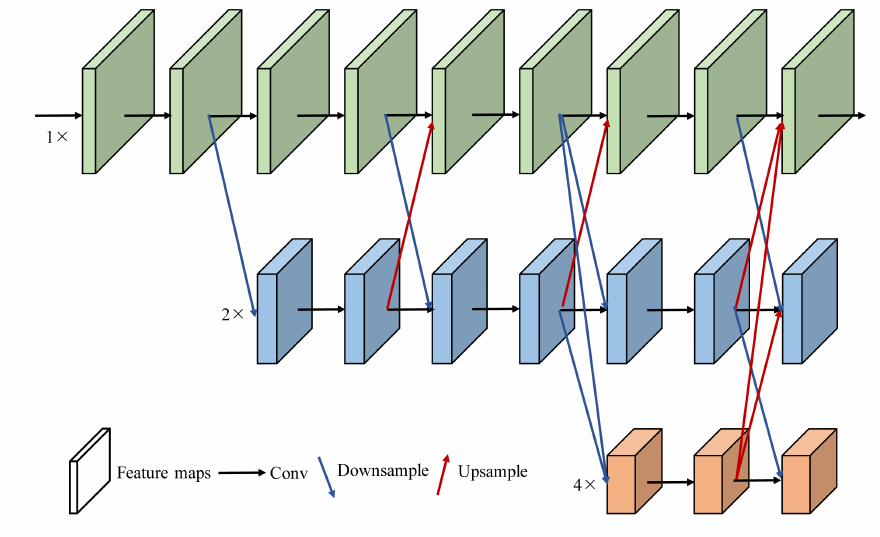
Figure 5. The basic architecture of HRNet